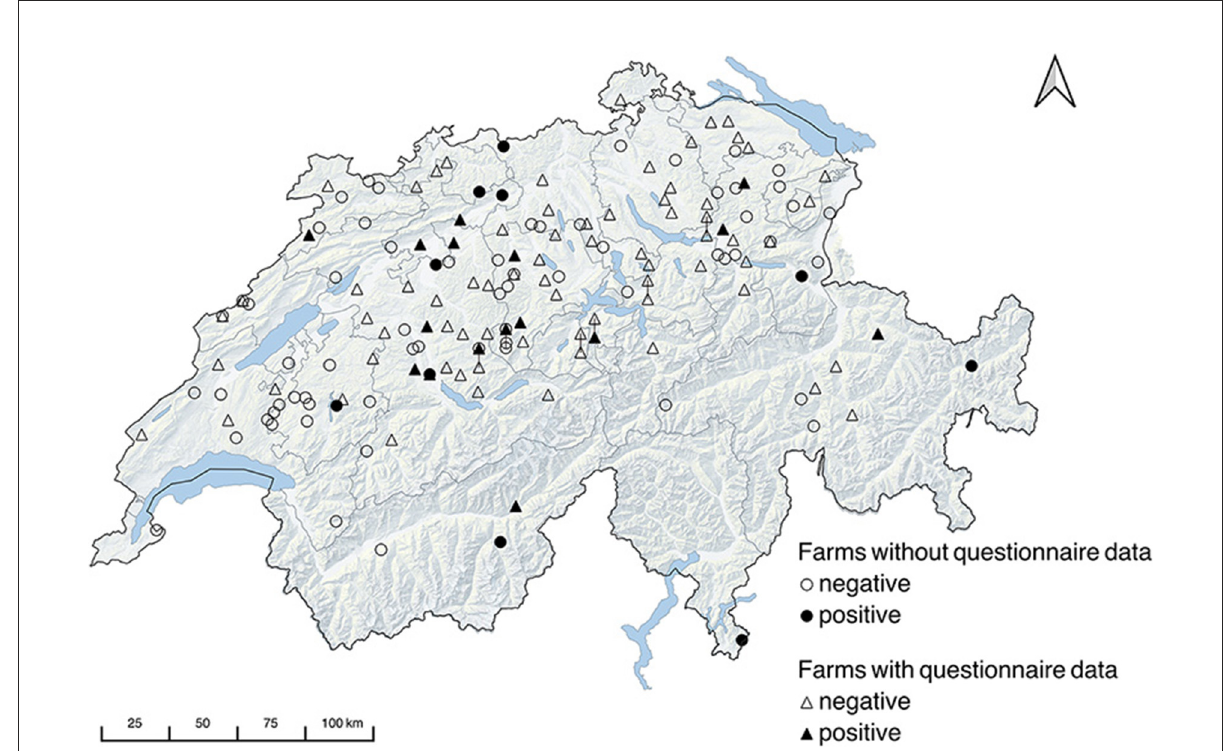
FIGURE1 Map of Switzerland with geographical distribution of the sampled farms plotted according to the zip code. Locations with identical zip codes are displaced by bars.